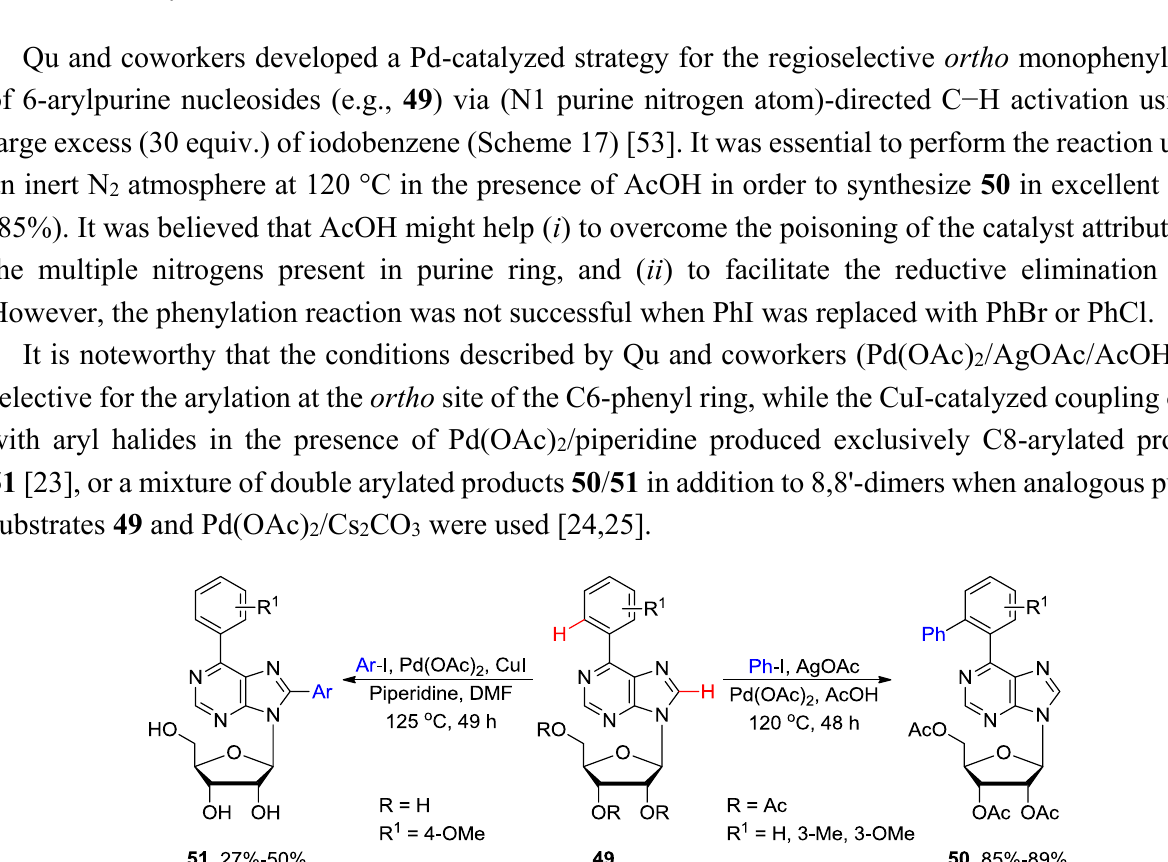
Scheme 16. Cu-catalyzed intramolecular direct ortho C-H activation/amination of 6- N